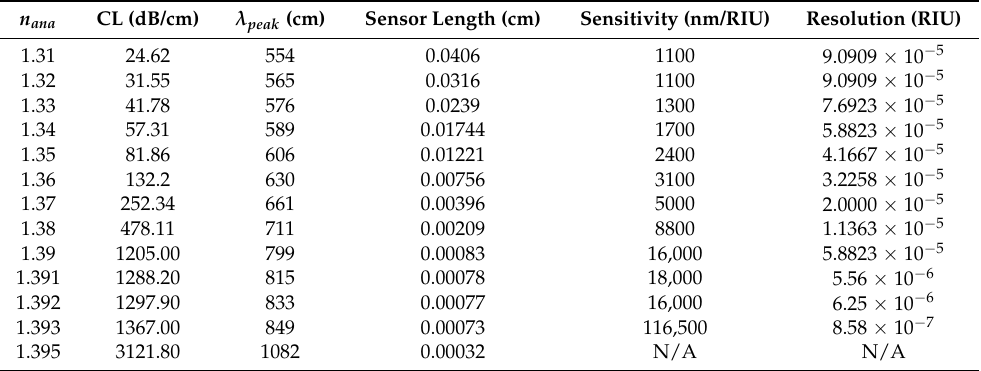
Table 5. Observation of the performance of the designed SPR-PCF sensor for variation of RIs in the interval of 1.31 – 1.395.